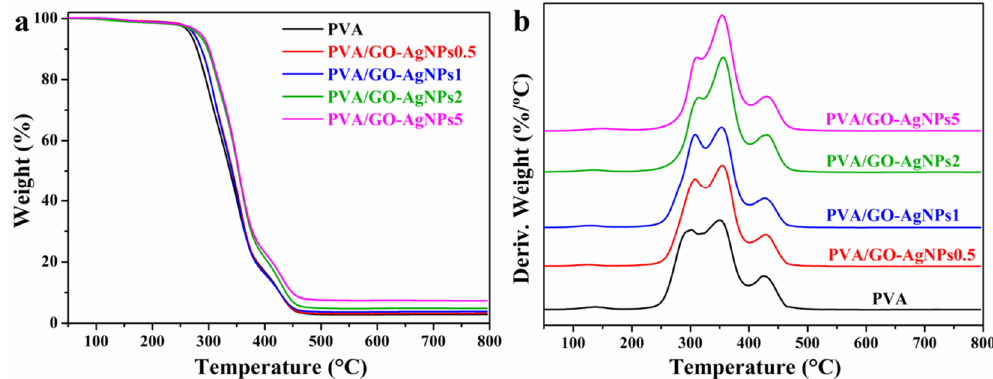
Figure 5. ( a ) TG and ( b ) DTG curves of neat PVA and PVA / GO–AgNPs nanocomposites in nitrogen. Table 3. TGA data for neat PVA and PVA / GO–AgNPs